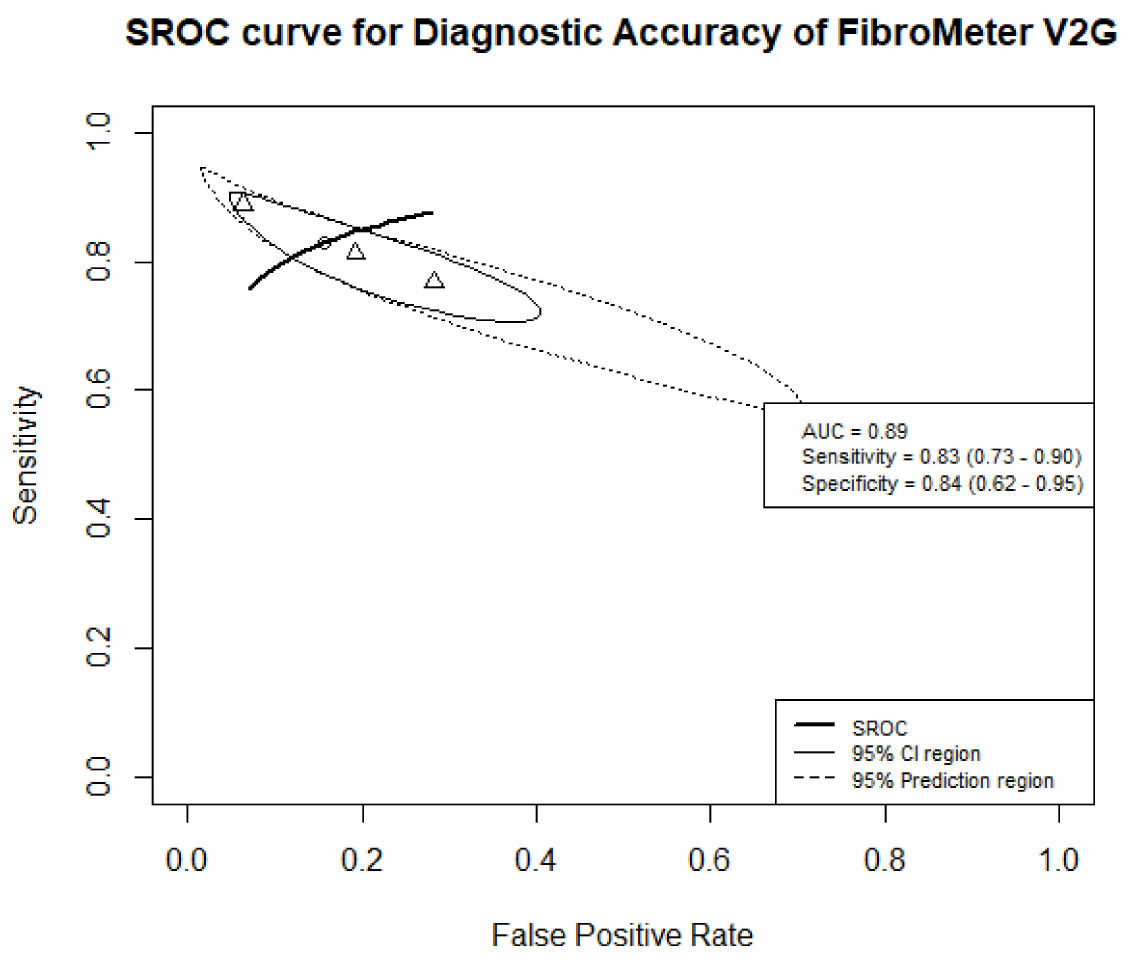
Figure 2. Summary receiver operating characteristic (SROC) curve of the diagnostic accuracy of FibroMeter V2G for target condition advanced fibrosis. The solid ellipse presents the 95% confidence interval region of diagnostic accuracy of FibroMeter V2G; the dotted ellipse presents the prediction region in which 95% of future diagnostic accuracy study estimates of FibroMeter V2G will fall. Triangles represent diagnostic accuracy estimates from each included study; circle presents the Youden Index threshold